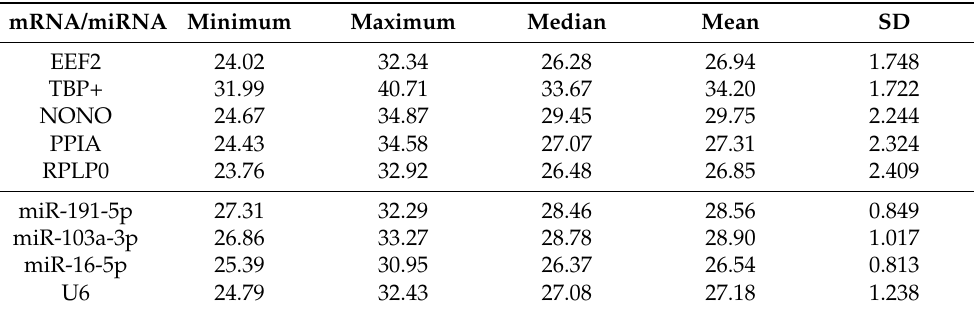
Table 3. Basic statistics of the Cq-values of candidate reference genes in archived FFPE colon samples of control and DSS-treated C57BL6/JOlaHsd mice (n=117). Legend: SD, standard deviation; TBP+, 16 of 117 FFPE samples were undetermined for TBP, therefore, only 101 FFPE samples in which TBP was expressed were included in the calculation. mRNA/miRNA